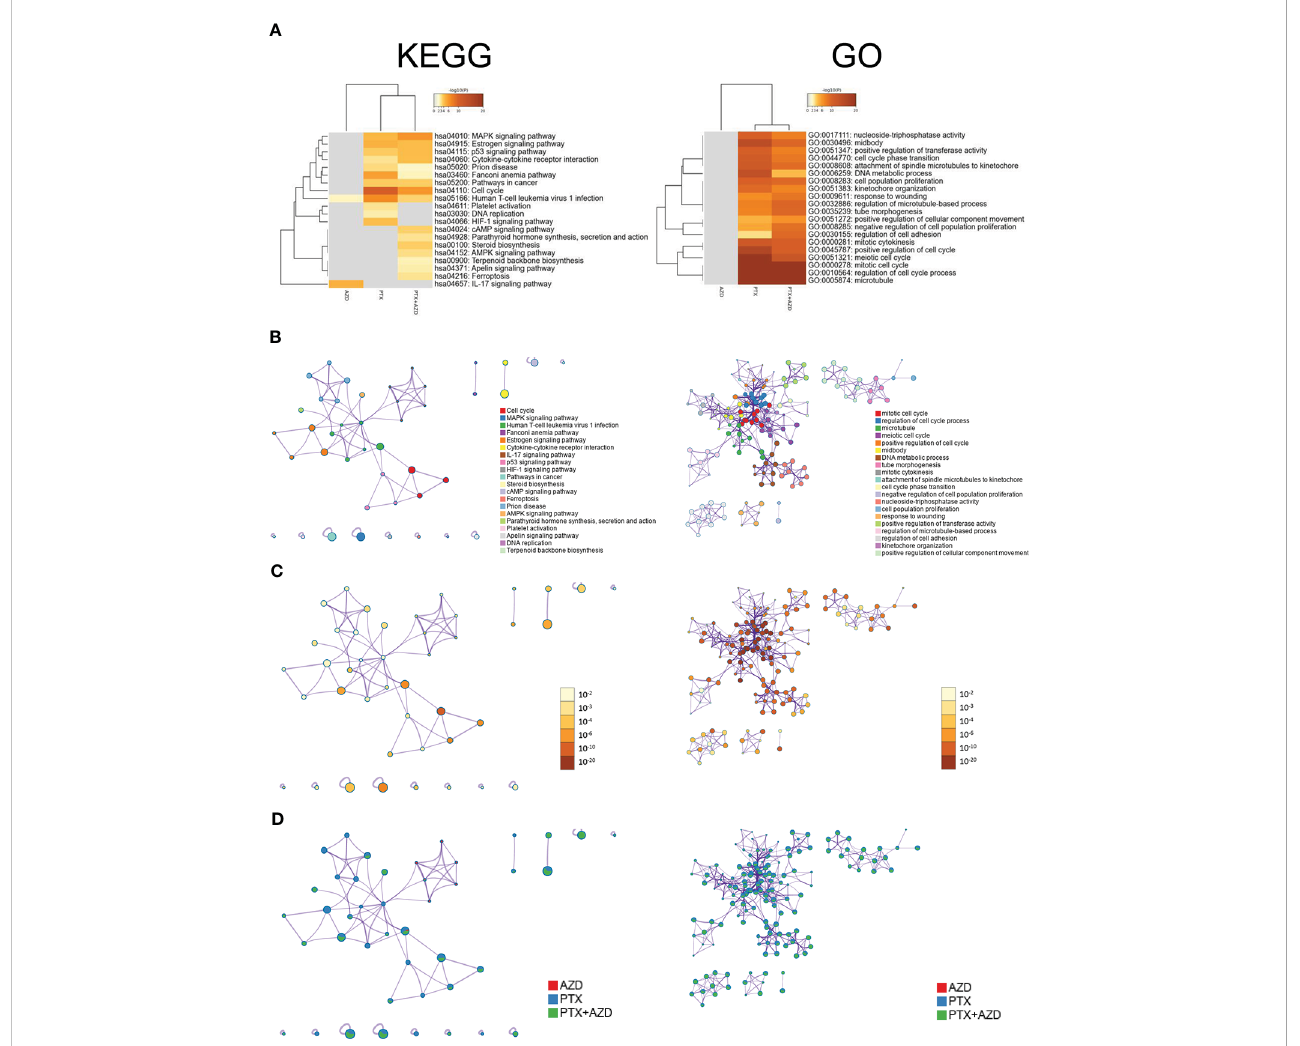
FIGURE 5 Functional enrichment analysis of DEGs (Left: KEGG. Right: GO). (A) Heatmap of enriched terms across input gene lists; the colors correspond to p values. The network of enriched terms is presented as follows: (B) colored based on cluster ID, where nodes that share the same cluster ID are typically close to each other; (C) colored by p value, where terms containing more genes tend to have a more signi fi cant p value; and (D) represented as pie charts, where pies are color-coded based on the identities of the gene